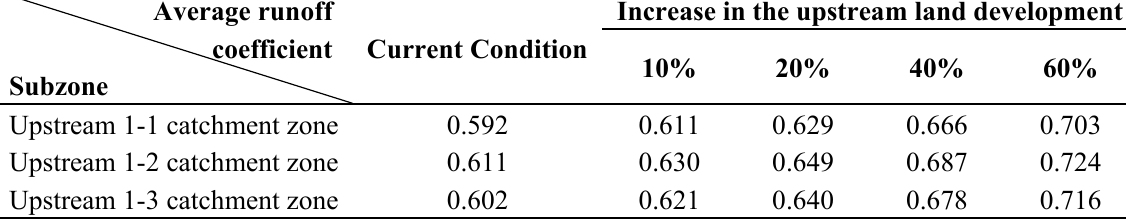
Table 2. Average runoff coefficients for various levels of land development in the upstream catchment area of the Po Cheng Keng